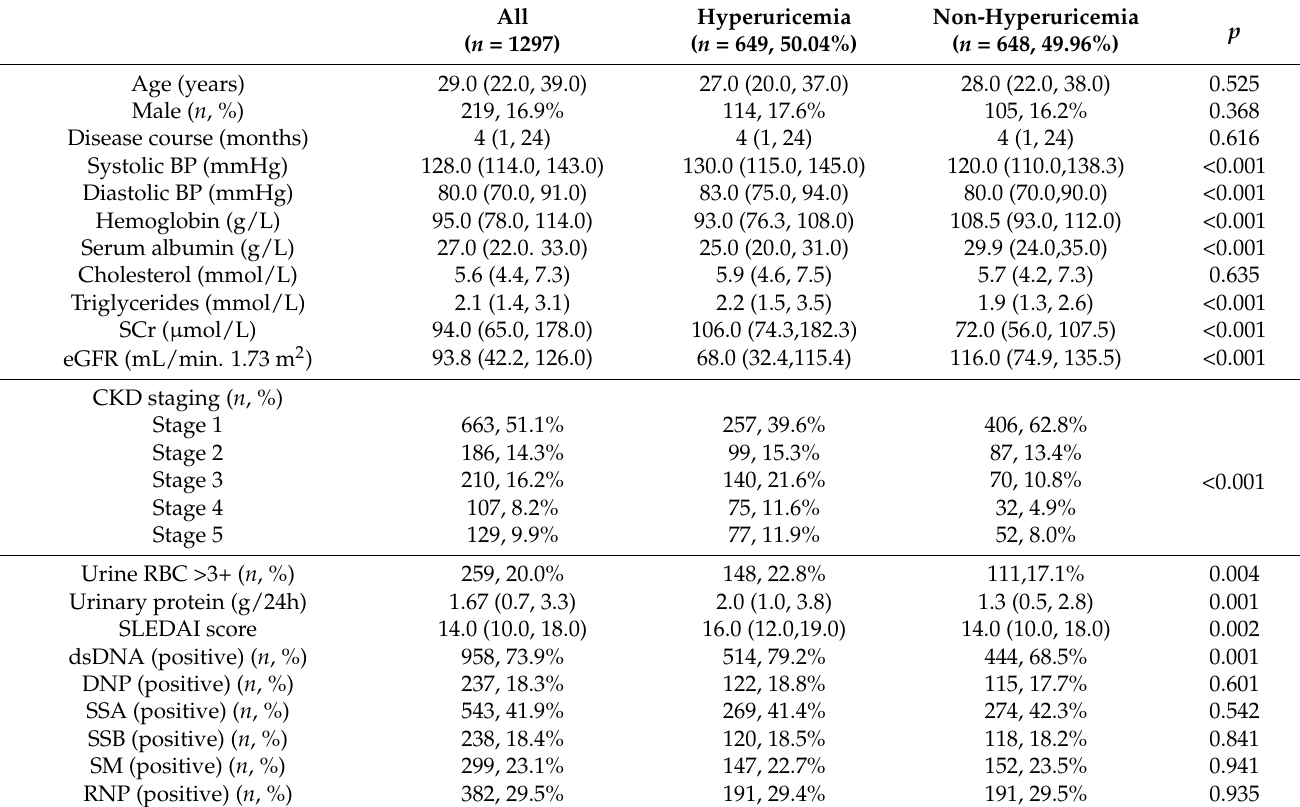
Table 1. Clinical characteristics of LN patients in the hyperuricemia and non-hyperuricemia groups. All ( n =